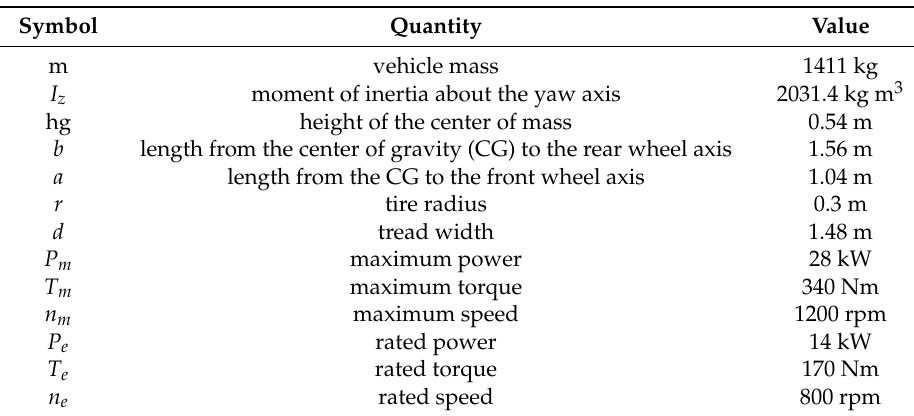
Figure 5. The path of the DLC maneuver. Table 2. Parameters of the 4MIDEV and hub motors.